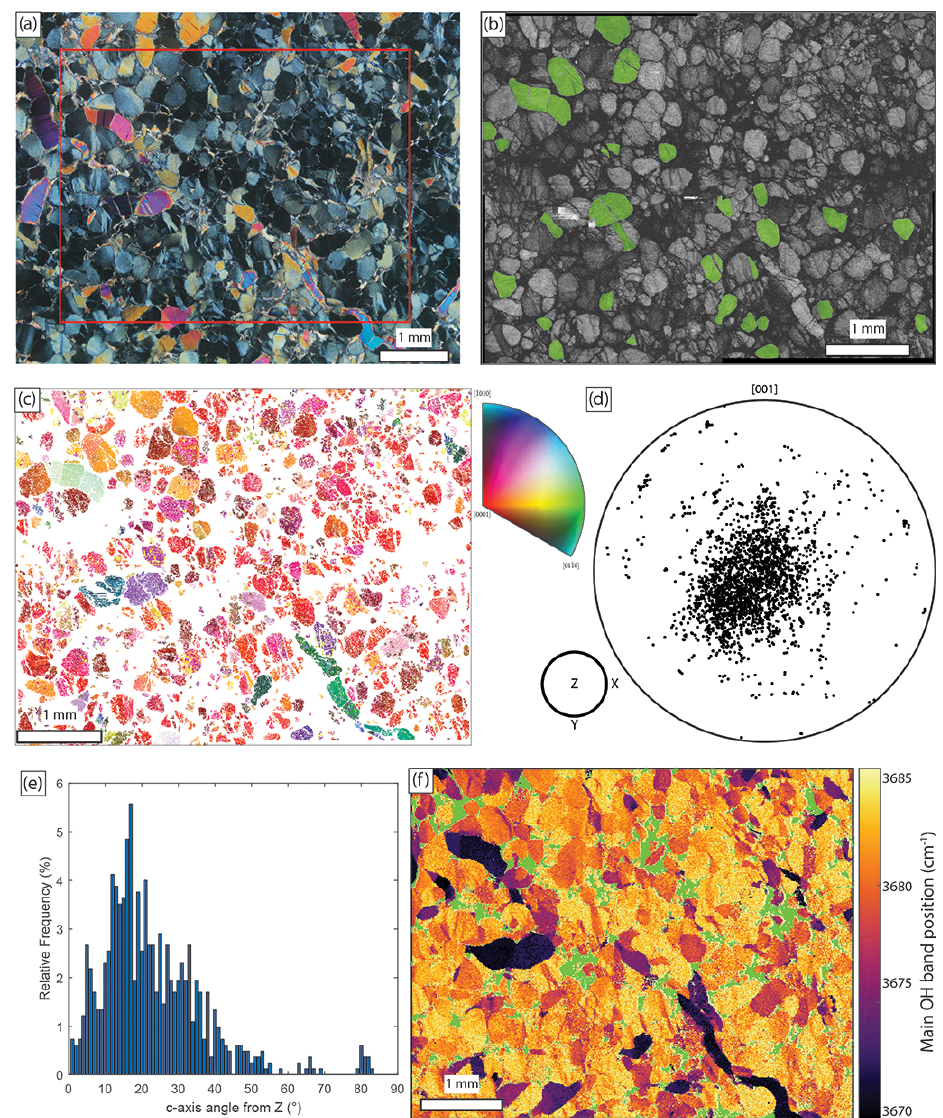
Figure 4. EBSD and Raman map 2 on thin section MF01 ⊥ . (a) Cross-polarised light photomicrograph with mapped area in the red box. (b) Image quality band contrast map with selected grains from the EBSD analysis highlighted in green. (c) Inverse pole figure (IPFZ) map coloured with the inverse pole figure scheme shown on the right. (d) Pole figures (lower-hemisphere equal area, one point per grain) of [001] orientation ( c -axis). (e) Histogram of the relative frequency of the c -axis angle from z for each grain. (f) Raman-based map displaying the position of the main OH-stretching band of lizardite. Green areas represent chrysotile-dominated